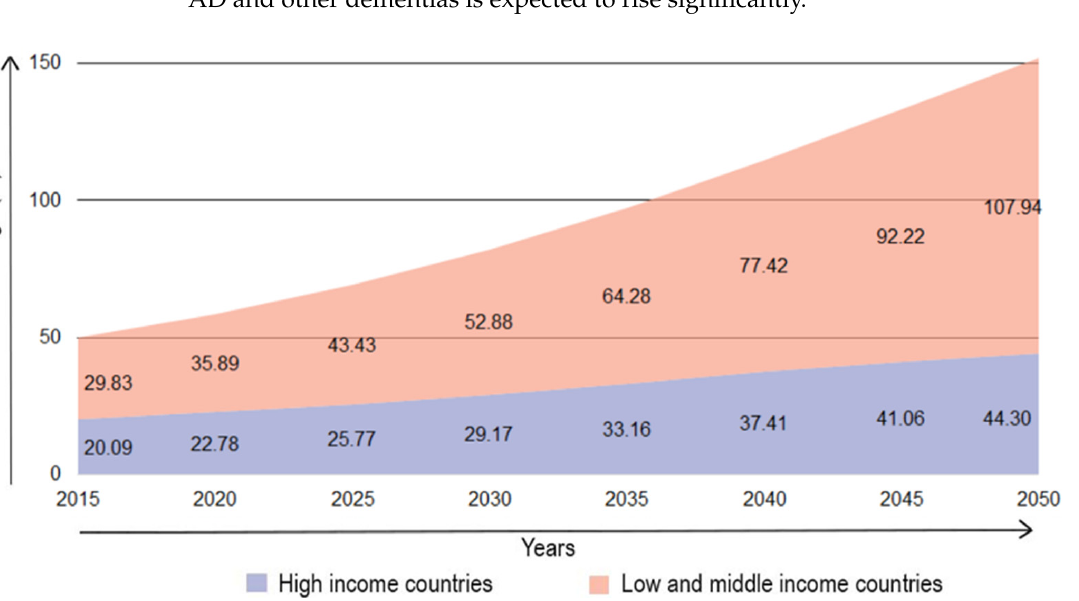
Figure 2. The number of people with dementia living in low and middle-income countries compared to high-income countries. “Adapted with permission from International et al. [2]. 2020, Alzheimer’s Disease International”.